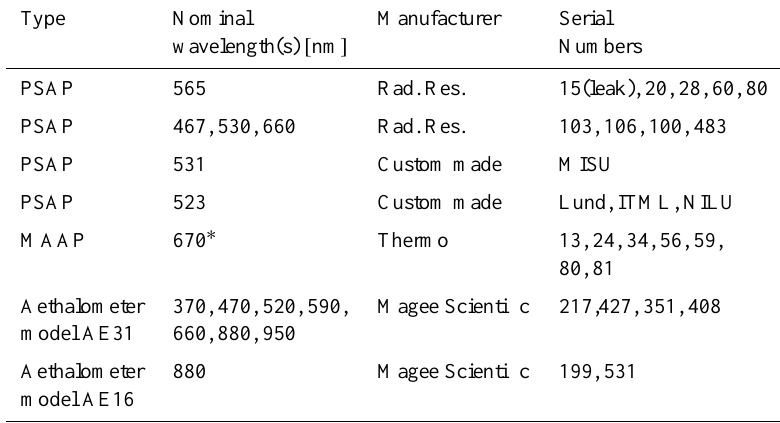
Table 5. Aerosol absorption photometers at the EUSAAR2007